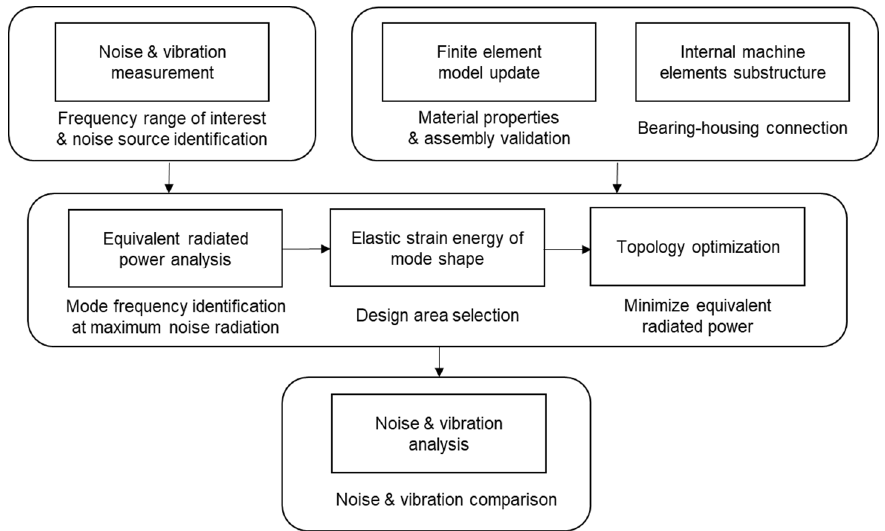
Figure 1. Flowchart for optimizing the shape of the gearbox housing.